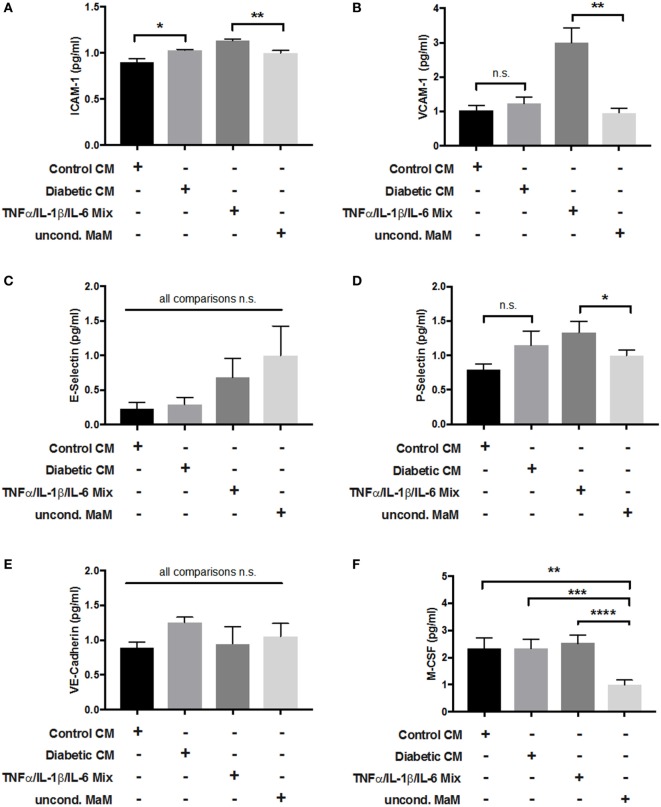
Adhesion molecule expression in endothelial cells in response to stimulation with macrophage-conditioned medium (CM). Placental arterial endothelial cells (pAECs) were incubated with macrophage CM from control and diabetic cells, and appropriate positive [tumor necrosis factor α (TNFα)/interleukin (IL)-1β/IL-6 mix] and negative controls [uncond. macrophage medium (MaM)]. Production of intracellular adhesion molecule 1 (ICAM-1) (A), VCAM-1 (B), E-selectin (C), P-selectin (D), vascular endothelial (VE)-cadherin (E), and macrophage colony stimulating factor (M-CSF) (F) in response to treatment was measured. Pools of supernatant from three macrophage isolations were used to prepare CM; the experiment was performed with n = 3 different primary pAEC isolations. One-way ANOVA. Data are shown as mean ± SEM.